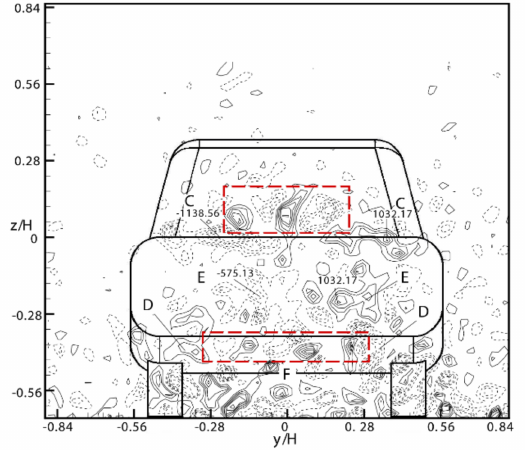
Figure 14. Iso-contours of instantaneous streamwise vorticity ω x in y–z plane at x/H = 0.28. Minimum and incremental values of vorticity are ω x,min = − 230.944 s − 1 , 280.708 s − 1 , and − 1 , respectively. ∆ ω x = 225.428 s